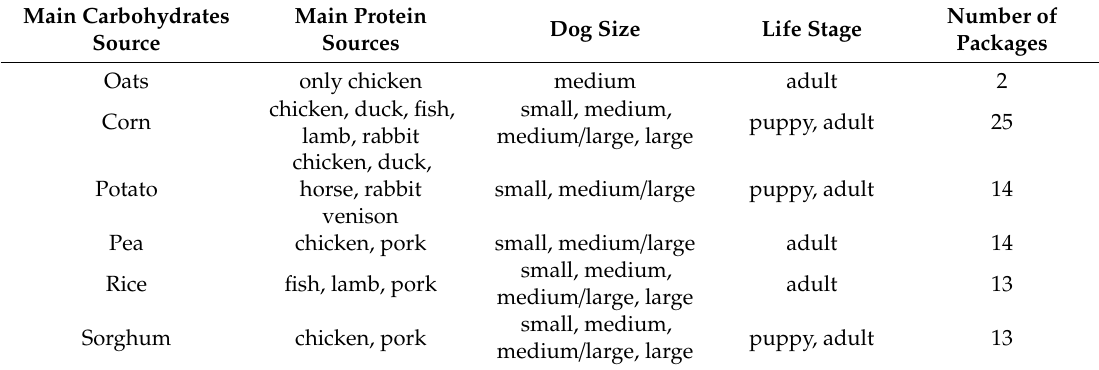
Table 1. Brief description of the commercial dry dog food samples included in the study.